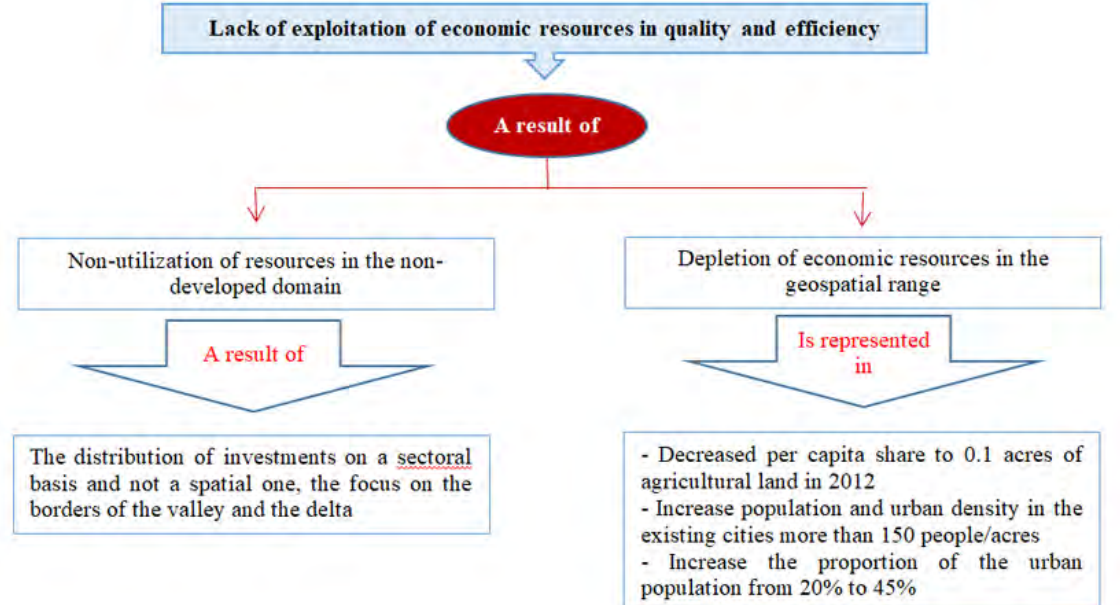
Figure 5. Lack of exploitation of economic resources in quality and efficiency